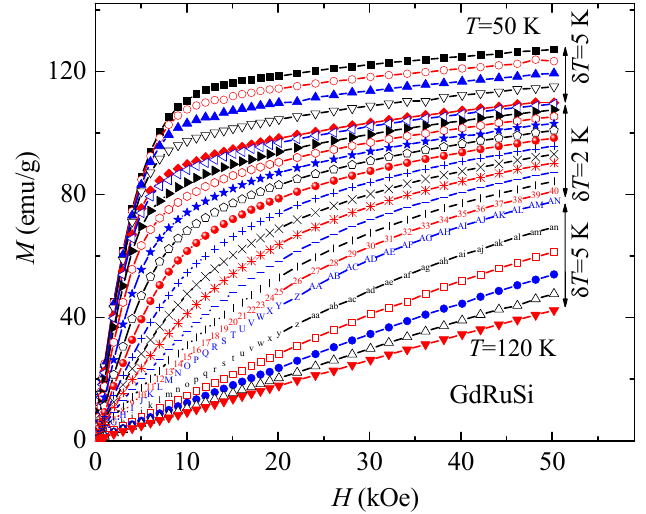
Figure 5. Magnetization isotherms M(H) of GdRuSi in the range T = 50–120 K (up-down). The tem- perature step is 5 K in the ranges 50–70, 95–120 K and 2 K in the range 71–95 K. Different colors for different symbols are made to better distinguish them. 71–95 K.